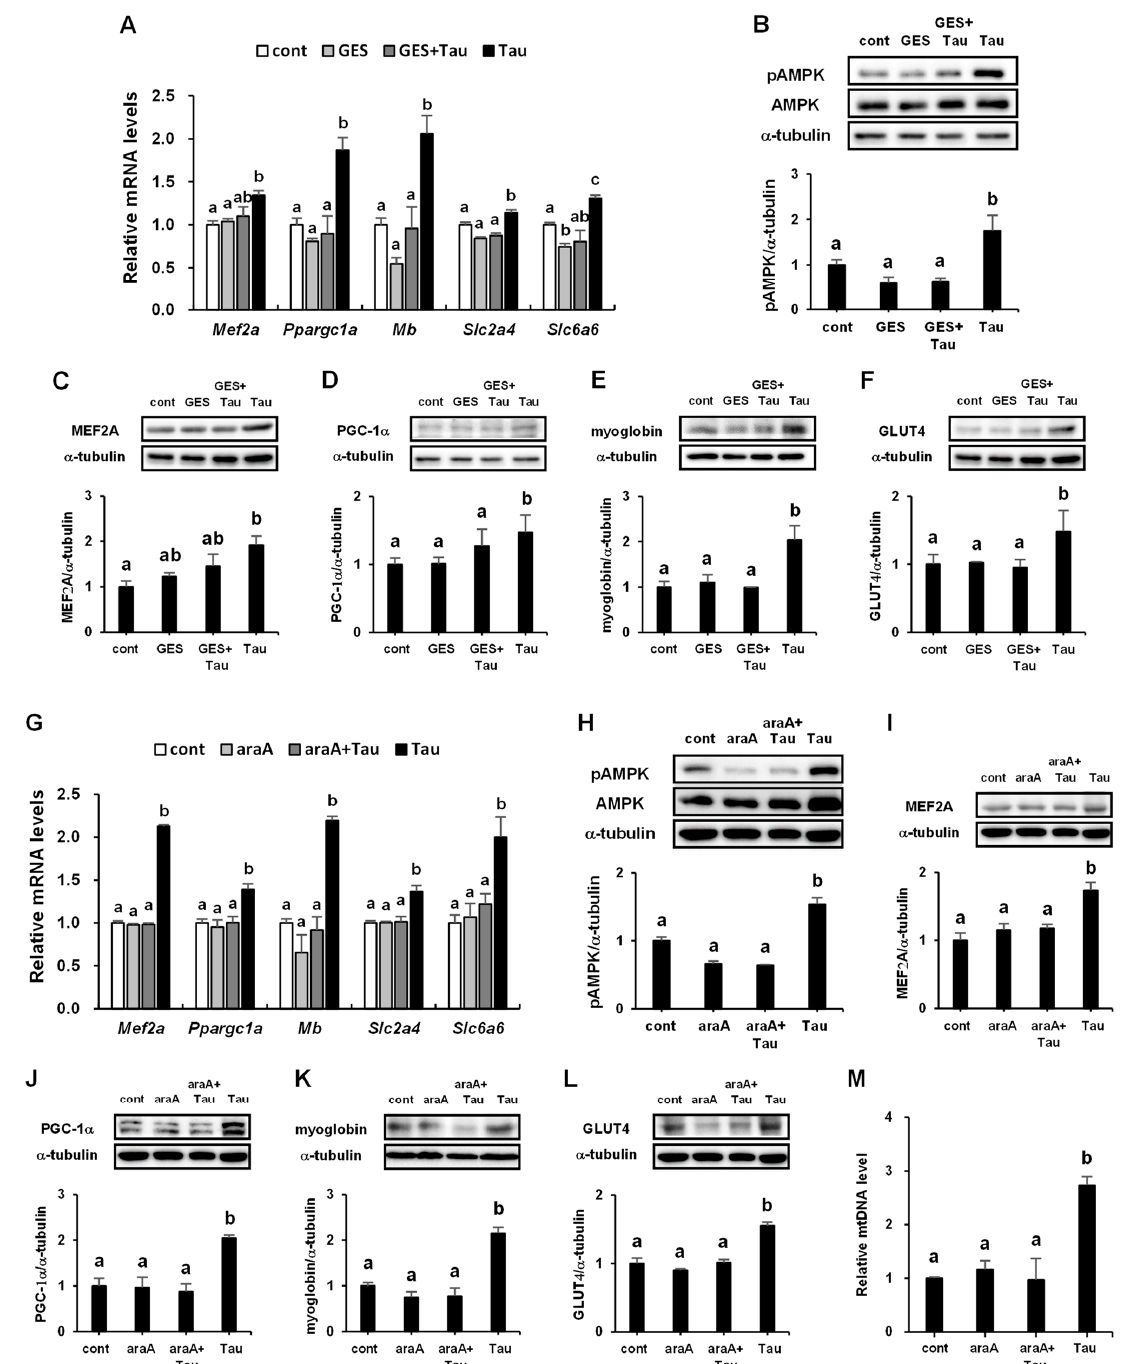
Figure 7. Effects of taurine transporter antagonist, guanidinoethyl sulfonate (GES), and AMPK inhibitor, adenine 9- β -D-arabinofuranoside (araA), on the stimulated phosphorylation of AMPK and expression levels of myogenic genes and proteins after treatment with taurine in L6 myotubes. L6 cells were treated with 0.3 mM taurine for 1 h in the presence or absence of 0.3 mM GES preincubated for 1 h ( A – F ) or 2 mM araA preincubated for 20 min ( G – M ) before treatment with taurine. After treatment, L6 cells were analyzed via qRT-PCR analysis ( A , G , M ) or Western blot ( B – F , H – L ), as described in the Materials and Methods section. Values shown represent the mean ± SE (n = 3–6). Results were analyzed using one-way ANOVA followed by Tukey’s test for multiple comparisons. Values with different superscript lowercase letters indicate significant differences ( p <